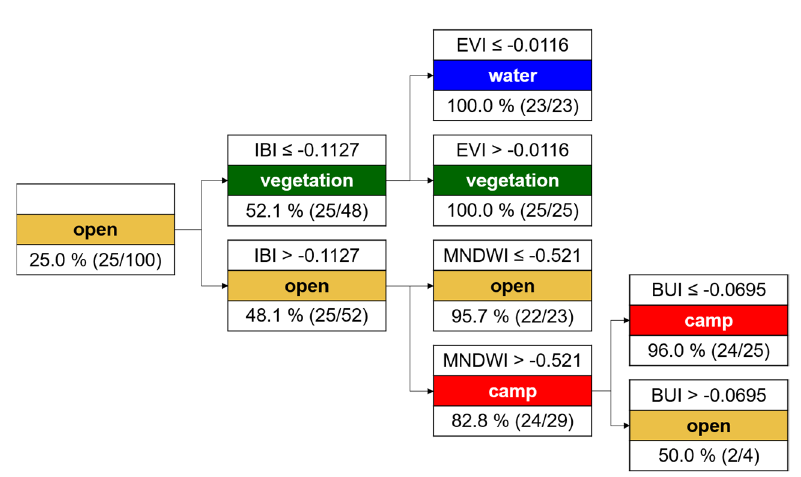
Figure A6. CART for July 2017.